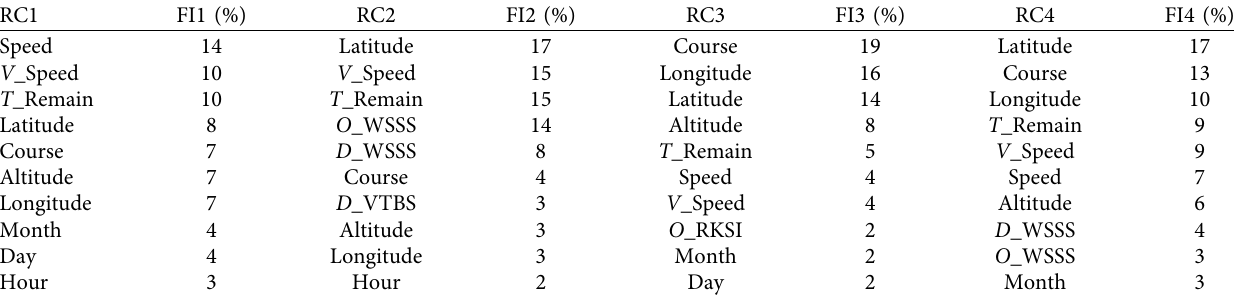
Table 8: Feature importance of random forest models for action prediction.